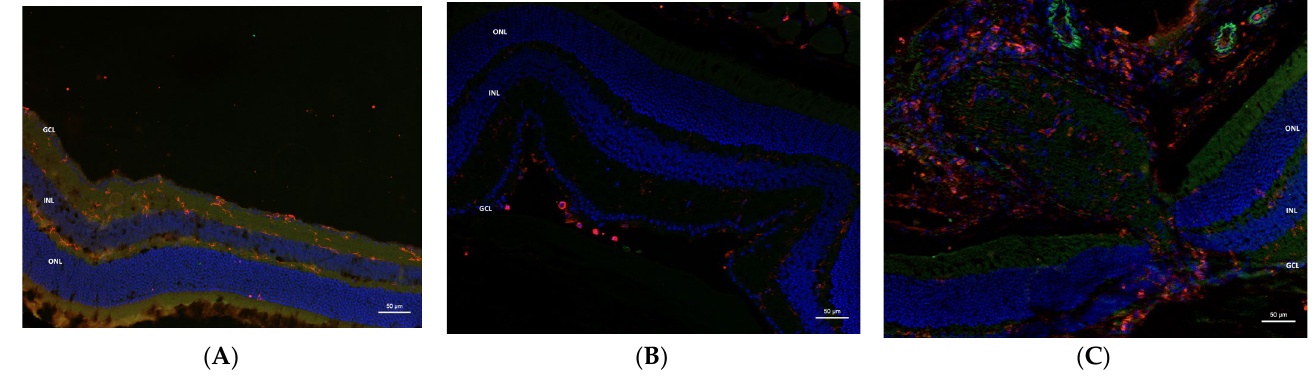
Figure 5. CD45 immunohistochemical staining in AZ-treated eyes: WT mice. ( A ) Eyes with microbead- induced glaucoma and treatment with AZ showed an inflammatory reaction in the inner retinal layers and a milder reaction in the outer plexiform layer. ( B ) No reaction was seen in the internal control left eyes. ( C ) The optic nerve of microbead-injected, AZ-treated eyes also had an intense inflammatory reaction. CD45, red; DAPI, blue; autofluorescence, green. AZ, azithromycin; WT, wild type.